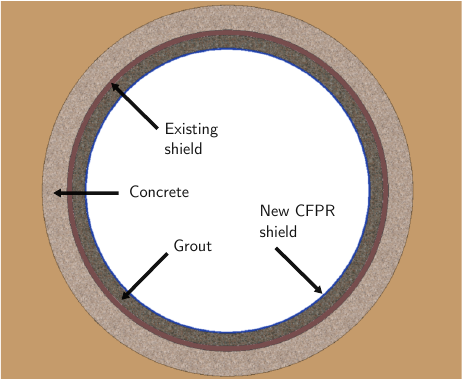
Figure 7. Alternative 4: internal structural coating with steel and